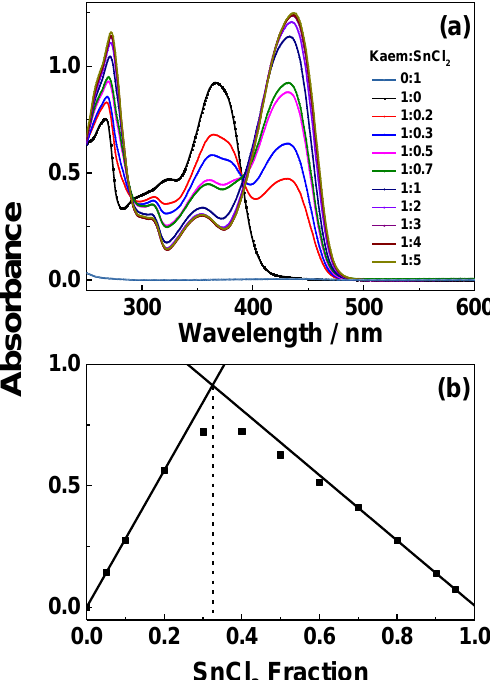
Figure 2. Determination of the Sn:Kaem ratio. ( a ) Absorption spectra of 50 µM HKaem, 50 µM SnCl 2 , and solutions of 50 µM HKaem addition of SnCl 2 in varying ratio (1:0.2 – 1:5) in ethanol. ( b ) Job’s plots of absorbance at 430 nm obtained by mixing solutions of HKaem and SnCl 2 with total concentration of 50 μM in HKaem:Sn(II) molar ratios varying from 9:1 to 1:9.